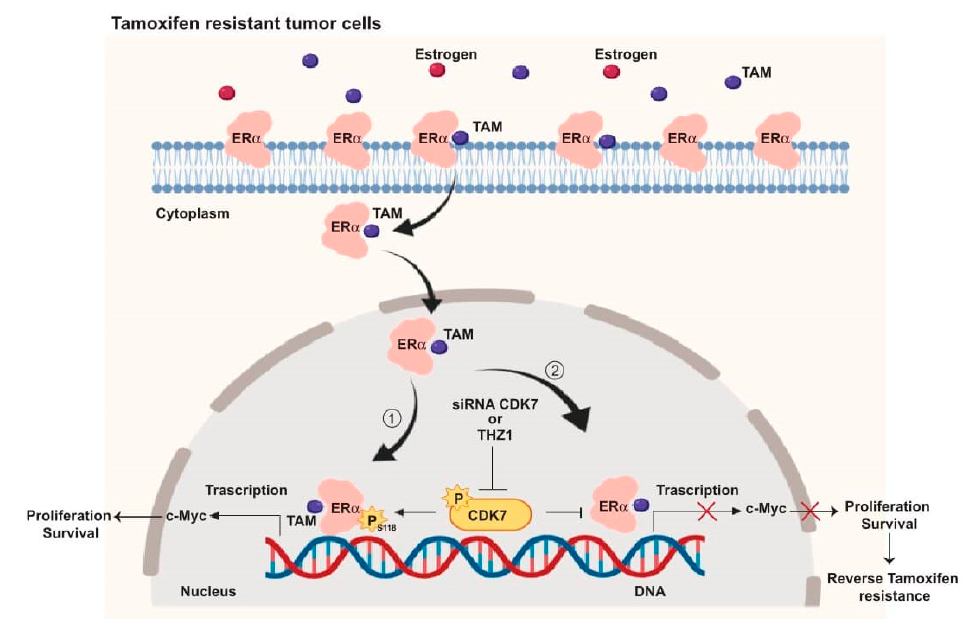
Figure 6. Schematic illustration of the CDK7 signaling pathway and how it interacts with ER and ER-regulating genes including MYC. ① CDK7 activates ER phosphorylation at serine 118, which augments MYC transcription. ② Targeting CDK7 by siRNA or THZ1 blocks ER phosphorylation and MYC expression which could restore tamoxifen (TAM) toxicity in resistant breast cancers.